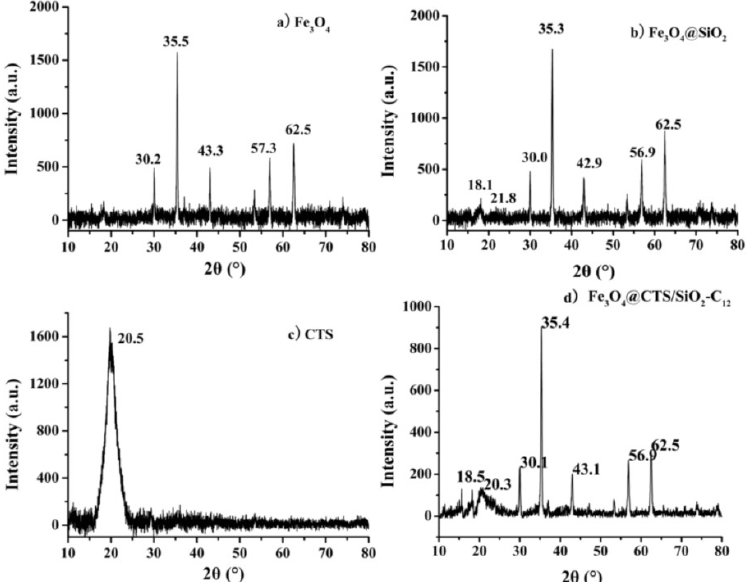
Figure 4. X-ray diffraction (XRD) patterns of: ( a ) Fe 3 O 4 ; ( b ) Fe 3 O 4 @SiO 2 composite; ( c ) CTS; and ( d ) Fe 3 O 4 @CTS/SiO 2 -C 12 composite.